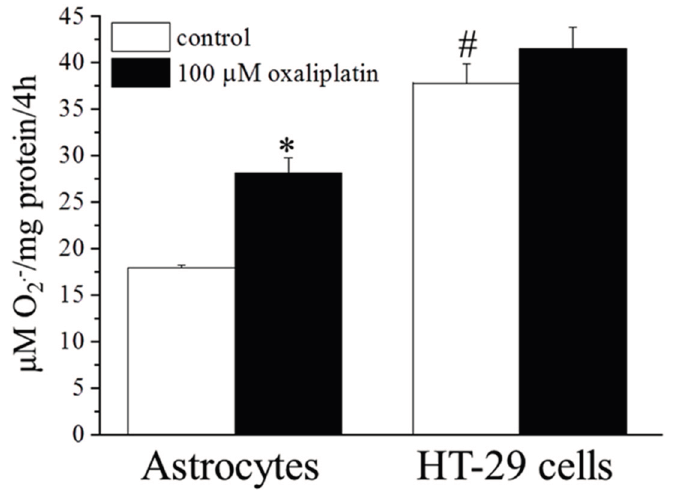
Figure 2. O 2. − concentrations. Astrocytes (5 × 10 5 cells/well) and HT-29 (3 × 10 5 cells/well) were exposed to 100 μ M oxaliplatin for 4 h. O 2. − concentration was evaluated by cytochrome C assay. The nonspecific absorbance was measured in the presence of superoxide dismutase (SOD; 300 mU/mL) and subtracted from the total value. Values are expressed as µM/mg protein/4 h. Bars represent the mean ± S.E.M. of three experiments. * p < 0.05 vs . control and # p < 0.05 vs. astrocytes